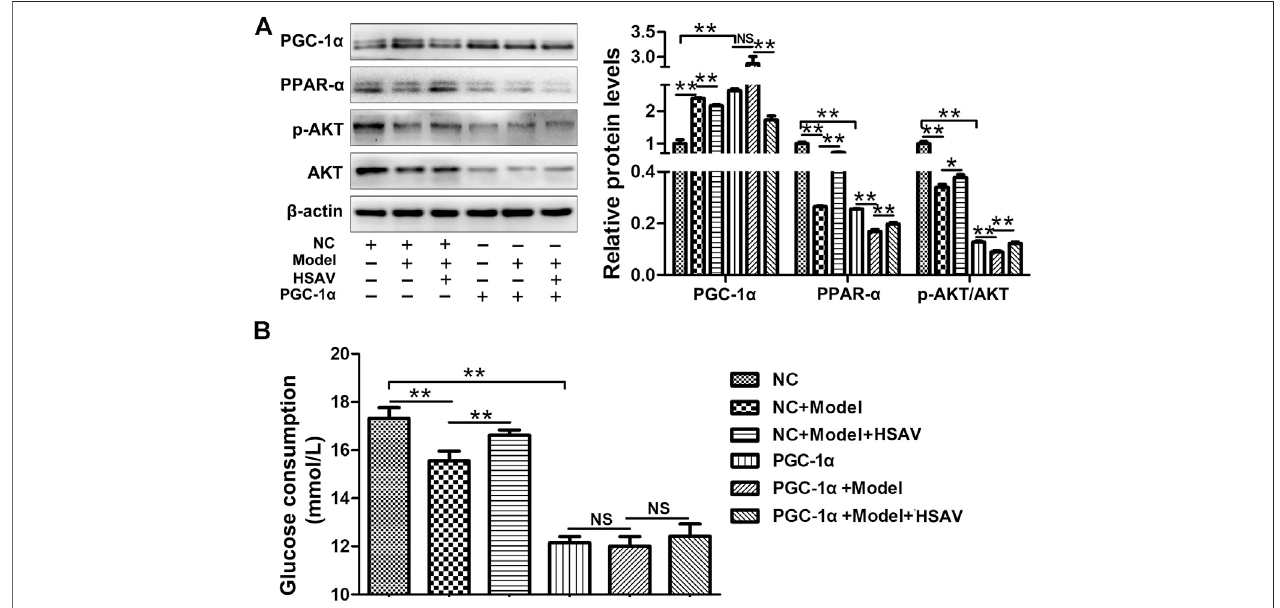
FIGURE 8 | Effects of HSAV on PGC-1 α pathway in HepG2 cells with PGC-1 α overexpression. (A) The expression levels of PGC-1 α , PPAR- α , AKT and p -AKT (n (cid:2) 3); (B) glucose consumption (n (cid:2) 6). Data are presented as the mean ± SD. * p < 0.05, ** p < 0.01, NS, no signi fi cance.